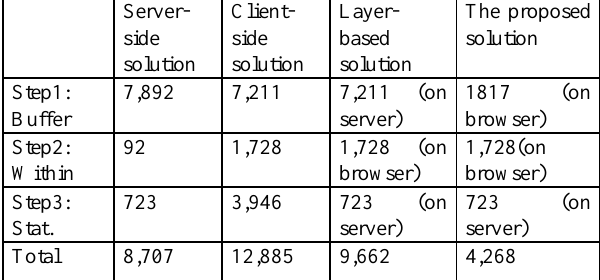
Table 3. Comparisons of the third case study (data amount is measured by